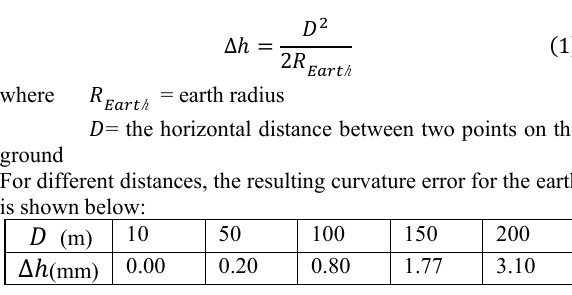
Table 1 . Elevation error caused by the curvature of the earth at different distances.